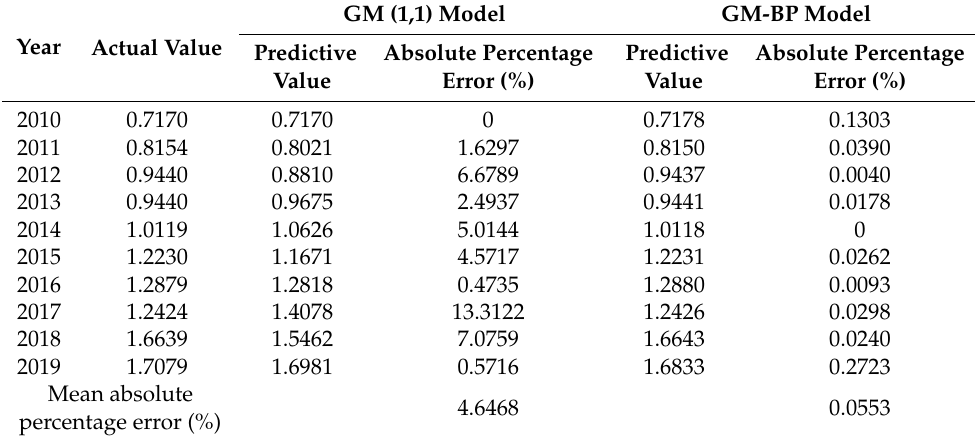
Table 7. The predictive results of RCA value of China’s computer information service